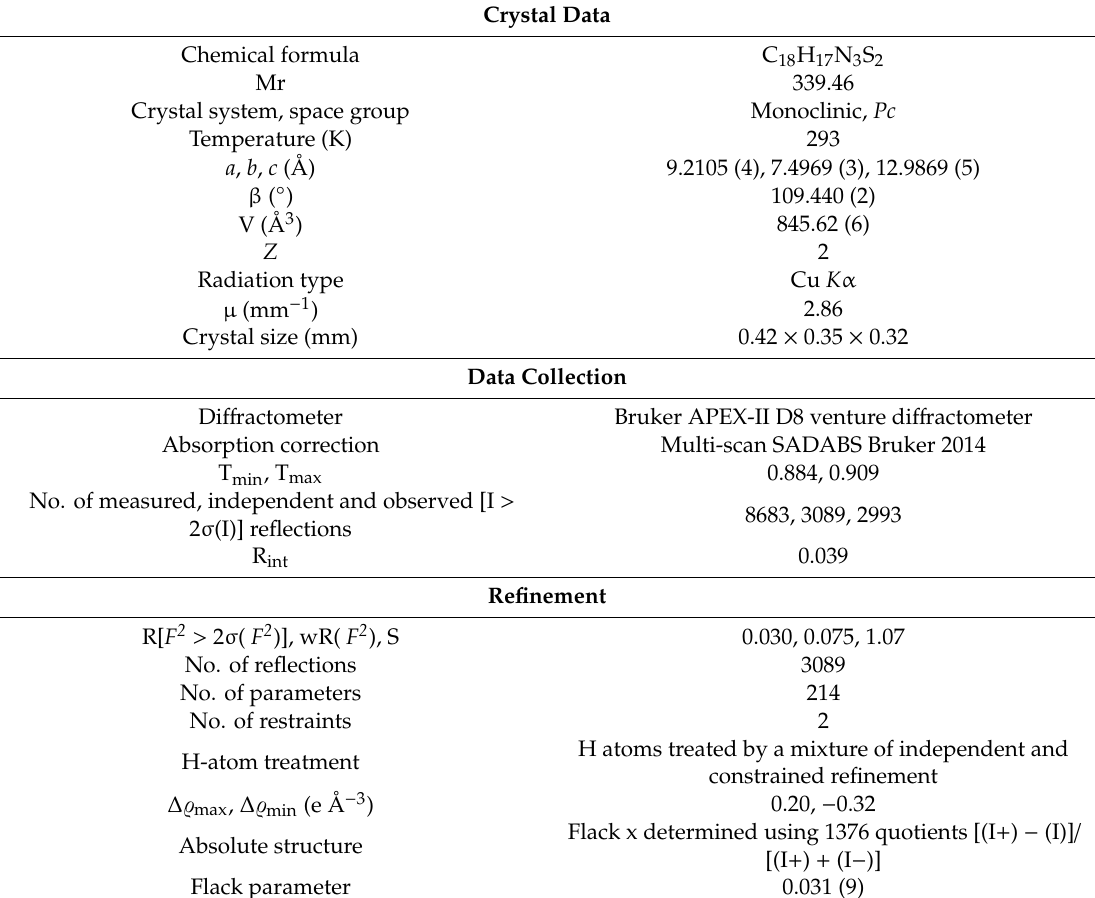
Table 1. The crystal and experimental data of thiazoline 5c